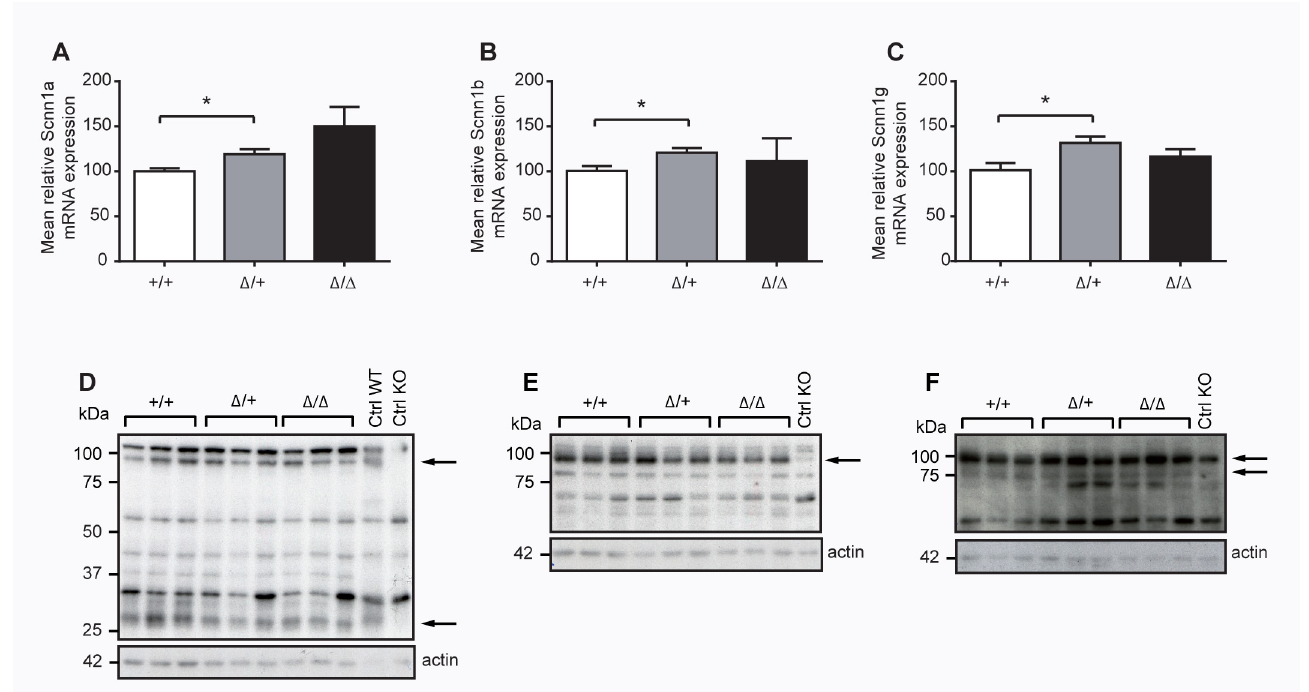
Fig 6. ENaC mRNA transcript and protein expression in kidneys from CAP2/ Tmprss4 wildtype (WT), heterozygous mutant (HET) and knockout (KO) mice under sodium-deficient diet. (A-C) Relative mRNA transcript and ( D-F ) protein expression of ( A ) Scnn1a , ( B ) Scnn1b and ( C) Scnn1g from CAP2/ Tmprss4 wildtype (WT), heterozygous mutant (HET), and knockout (KO) mice; n = 4 for each group and genotype; β -actin was used as internal control. Representative immunoblots of ( D) Scnn1a, ( E ) Scnn1b and ( F ) Scnn1g and its corresponding β -actin protein expression from CAP2/ Tmprss4 wildtype (WT), heterozygous mutant (HET) and knockout (KO) mice (n = 5 for each group and genotype); kidney extracts from Scnn1 wildtype (WT) and knockout (KO) mice were used as positive and negative control respectively; arrows indicate the full-length and the corresponding cleaved ENaC fragments; * P < 0.05).